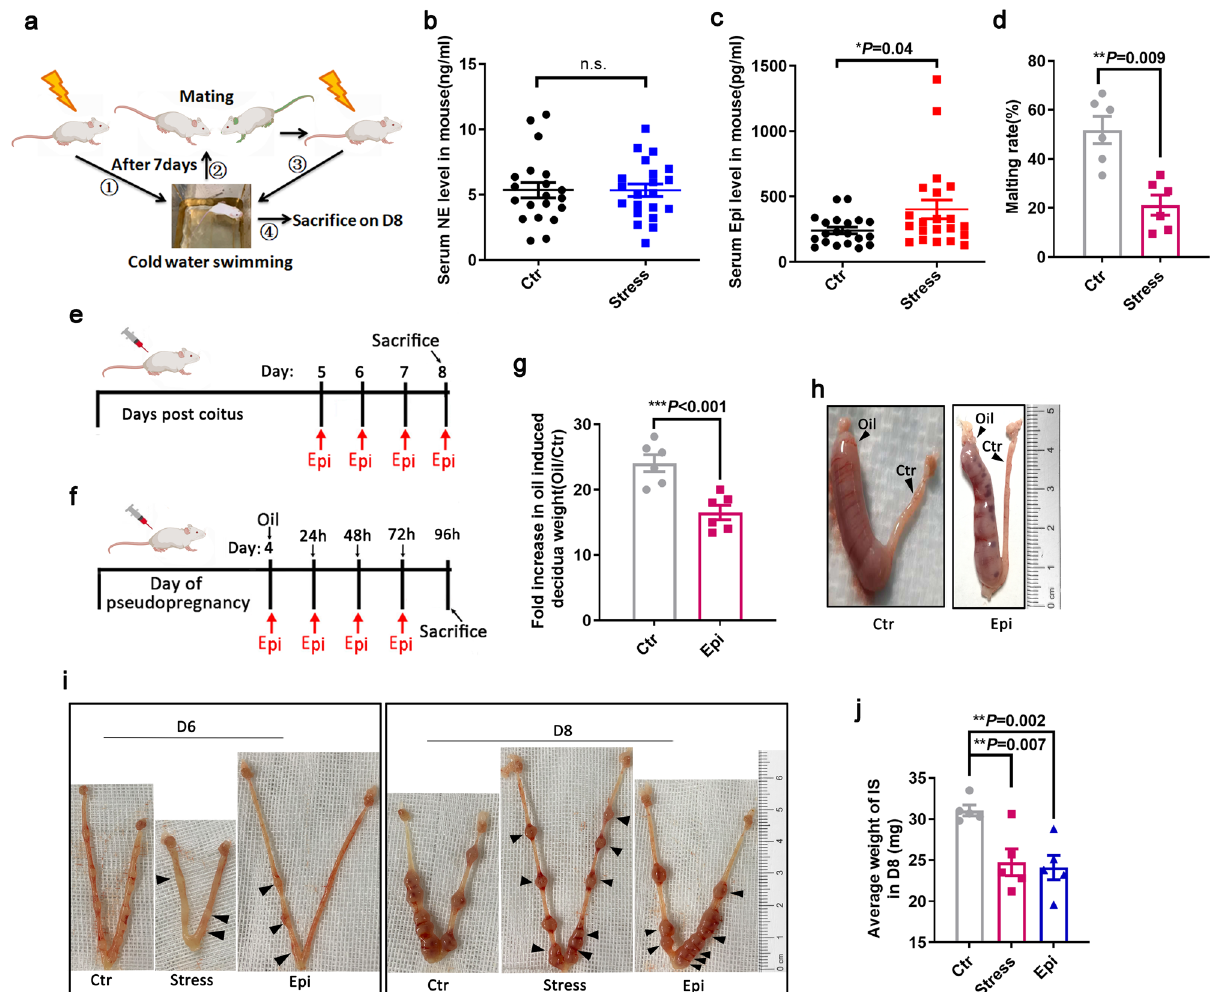
Fig. 6 Exposure of endogenous and exogenous epinephrine impaired decidua and embryo development. a Schematic diagram of experimental design of stressed mouse model. b , c Serum epinephrine and norepinephrine levels in stressed mice ( n = 21) versus control mice ( n = 20). d Mating rate of stress mice was signi fi cantly decreased ( n = 6) versus control mice ( n = 6). e Schematic diagram of experimental design for exogenous epinephrine exposure. f Schematic design of pseudopregnant mice exposed to exogenous epinephrine. g The fold increased after oil-induced decidual weight. Ctr, ( n = 6); Epi, ( n = 6). h Morphological deference of pseudopregnant uterus after 96 h of oil induction between vehicle and 100 μ g/mouse epinephrine treatment. Ctr, Non-decidualization ( n = 6); Oil, arti fi cial decidualization ( n = 6). i At D6 and D8, representative images of intrauterine embryos in mice exposed to exogenous epinephrine and stressed mice were compared with controls. Arrows indicate planting sites with growth restriction. j The average weight of IS was decreased in stressed and exogenous epinephrine exposed mice at D8. IS implantation